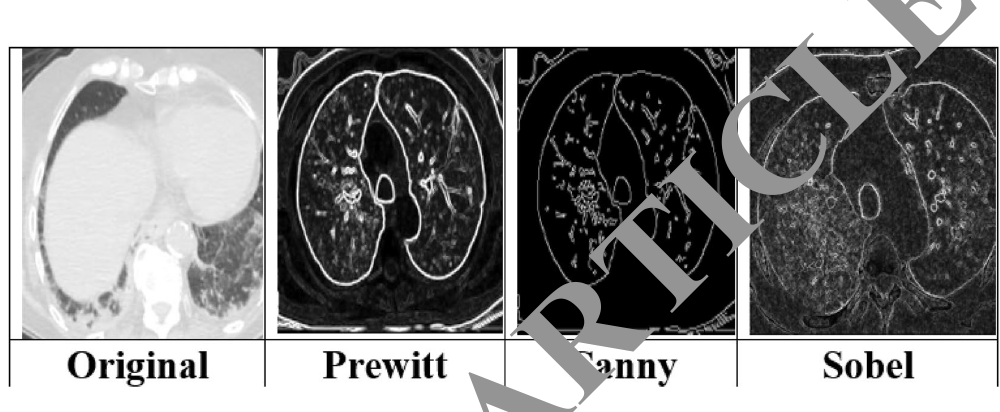
Figure 6. Comparison between original COVID-CT image and edge image after applying—Prewitt, Canny and Sobel filters respectively (raw image source: COVID-CT dataset 11